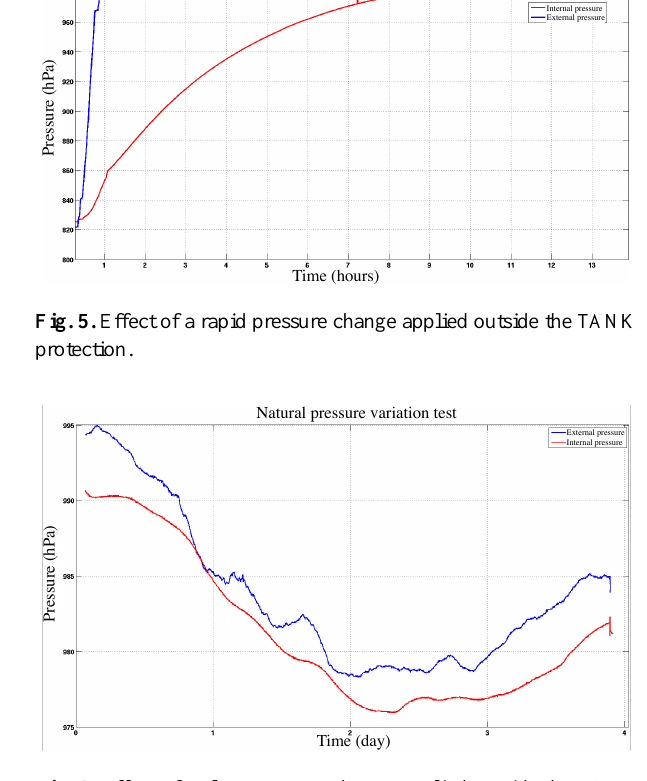
Fig. 6. Effect of a slow pressure change applied outside the TANK protection